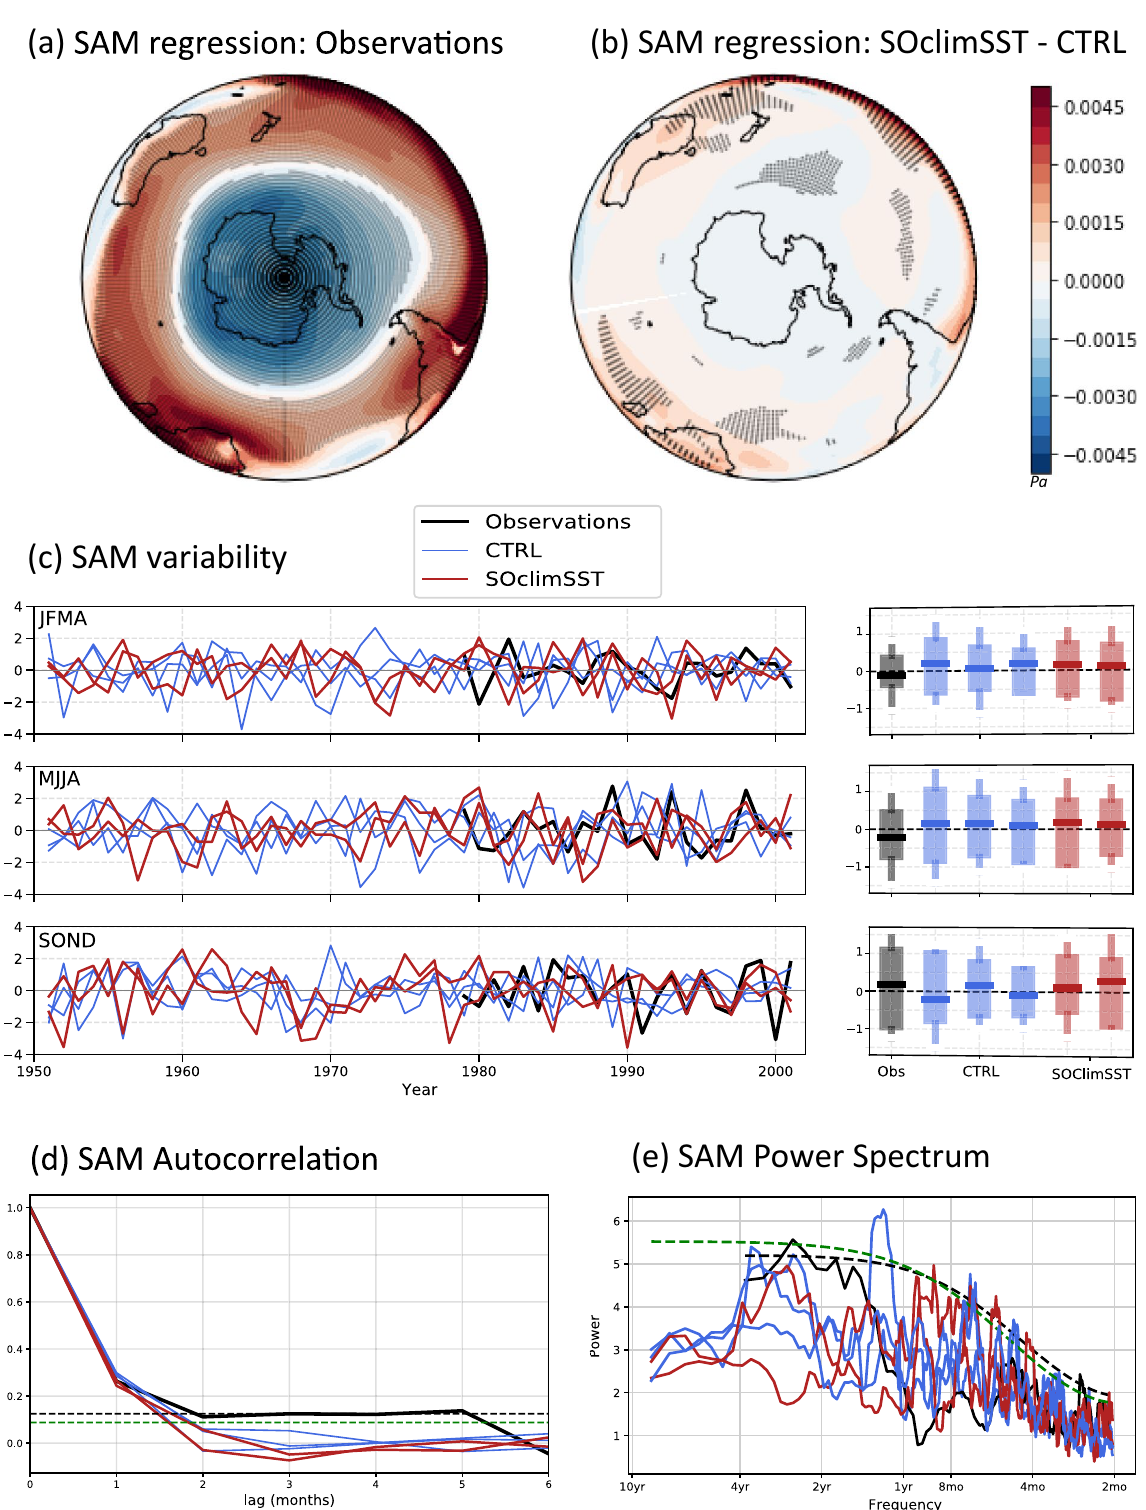
Figure 2. ( a ) Regression of monthly MSLP anomalies onto SAM in ERA5 reanalyses (1979–2001), and ( b ) difference between the regression of monthly MSLP anomalies onto SAM in SOclimSST runs and the regression of monthly MSLP anomalies onto SAM in CTRL runs (1951–2001). As in Fig. 1, stippling indicates robustness in the sign of the ensemble-mean difference, where the sign of all six individual differences (each SOclimSST run minus each CTRL run) is the same. ( c ) SAM timeseries for observations and each simulation for JFMA, MJJA and SOND, with corresponding bar plots on the right showing the median, 25th and 75th percentiles and ± one standard deviation for each timeseries. ( d ) Autocorrelation, and ( e ) power spectrum density in SAM across observations, CTRL and SOClimSST, with dashed lines showing the 95% confidence level for observations (black) and model runs (green). SAM has been calculated based on the Gong and Wang (1999) definition 35 and all monthly data has been linearly detrended prior to analysis. Figure produced using Python (https:// docs. python. org/3.